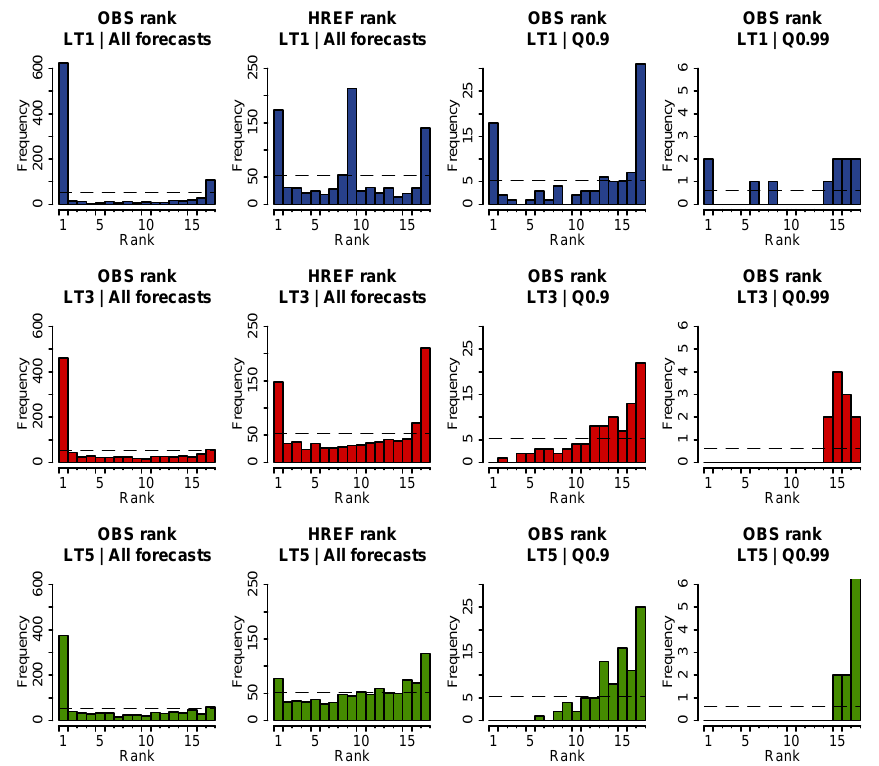
Fig. 5. Rank histograms for the daily maximum Sihl discharge in Zurich. The rank of OBS or HREF, within the 16 daily maxima forecast by the ensemble members, is depicted for lead times of 1, 3 and 5 days (LT1, LT3 and LT5). Histograms of the two first columns are based on the whole time series. For the two last columns, only days with an observed discharge exceeding Q 0 . 9 and Q 0 . 99, respectively, are included. Perfect rank uniformity is indicated by the horizontal dashed